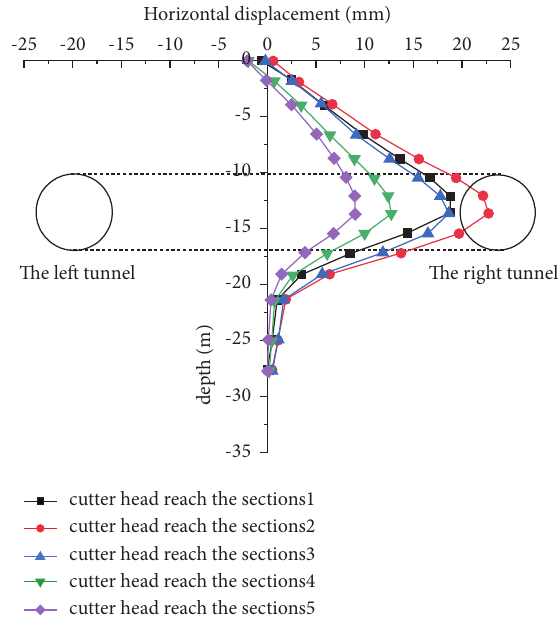
Figure 20: The right tunnel excavation gap is not filled.